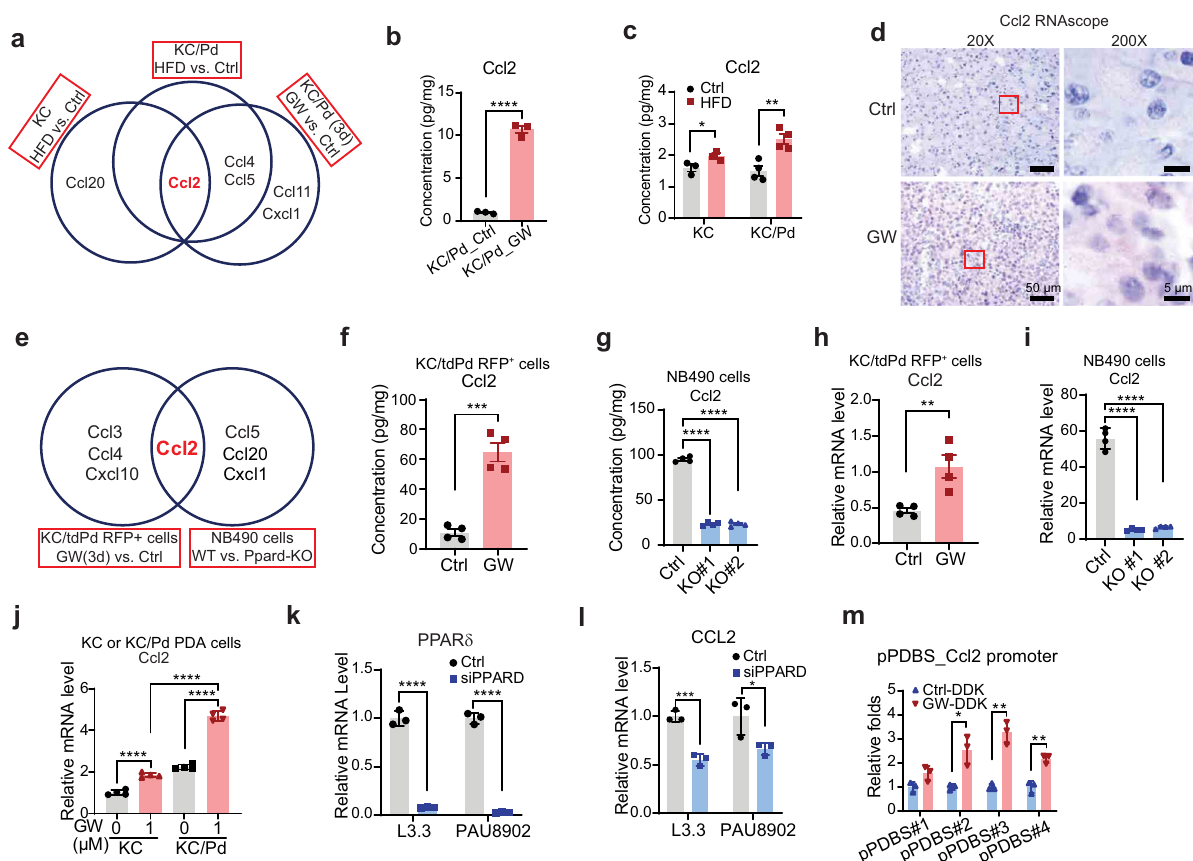
Fig. 6 PPAR δ alteration directly modulates chemokine CCL2 expression in mouse and human pancreatic epithelial cells. a – c Pancreatic tissues from KC or KC/Pd mice fed the HFD or Ctrl diet; and KC/Pd mice fed the GW or Ctrl diet for 3 days ( n = 3 – 4 biologically independent samples). Venn diagram of differentially expressed chemokines ( a ). Quantitative results of Ccl2 protein levels for KC/Pd mice on the GW diet ( b ) and KC or KC/Pd mice on the HFD ( c ). d Representative images of Ccl2 RNAscope in situ hybridization for normal pancreatic tissues of KC/Pd mice fed the GW or Ctrl diet for 3 days ( n = 3 biologically independent samples). e Venn diagram of differentially expressed chemokines for mouse tdTomato RFP – sorted pancreatic epithelial cells of KC/tdPd mice on GW or control diet for 3 days and for the cell culture media from mouse NB490 KPC cells with WT or Ppard KO. f , g Quantitative results of Ccl2 protein levels for tdTomato-RFP + cells ( f , n = 4 biologically independent samples) and for the cell culture media from mouse NB490 KPC cells from 4 independent experiments ( g ). h , i Ccl2 mRNA expression levels in tdTomato-RFP + pancreatic epithelial cells ( h , n = 4 biologically independent samples) and in mouse NB490 KPC cells from 4 independent experiments ( i ). j Ccl2 mRNA expression levels in mouse KC and KC/Pd PDAC cells with or without GW treatment from 4 independent experiments. k , l PPAR δ ( k ) and CCL2 ( l ) mRNA expression levels in human PDAC cells transfected with PPAR δ siRNAs (siPPARD) or control siRNA (Ctrl) from 3 independent experiments. m The PPAR δ binding to the four predicted PPAR δ binding sites (pPDBS) in the mCcl2 promoter in mouse KC PDAC cells stably transduced with mouse DDK-tagged PPAR δ expressing lentivirus and treated with 1 µ M GW or solvent (DMSO) from 3 independent experiments. Data are mean ± SEM. For ( b ), ( f ), ( h ), unpaired two-tailed Student ’ s t test, for ( c ), ( k – m ), multiple t -tests, for ( g ), ( i ), one-way ANOVA with Bonferroni correction, and for ( j ), two-way ANOVA with Bonferroni correction. * P < .05, ** P < .01, *** P < .001, and **** P < .0001. Source data are provided as a Source Data fi